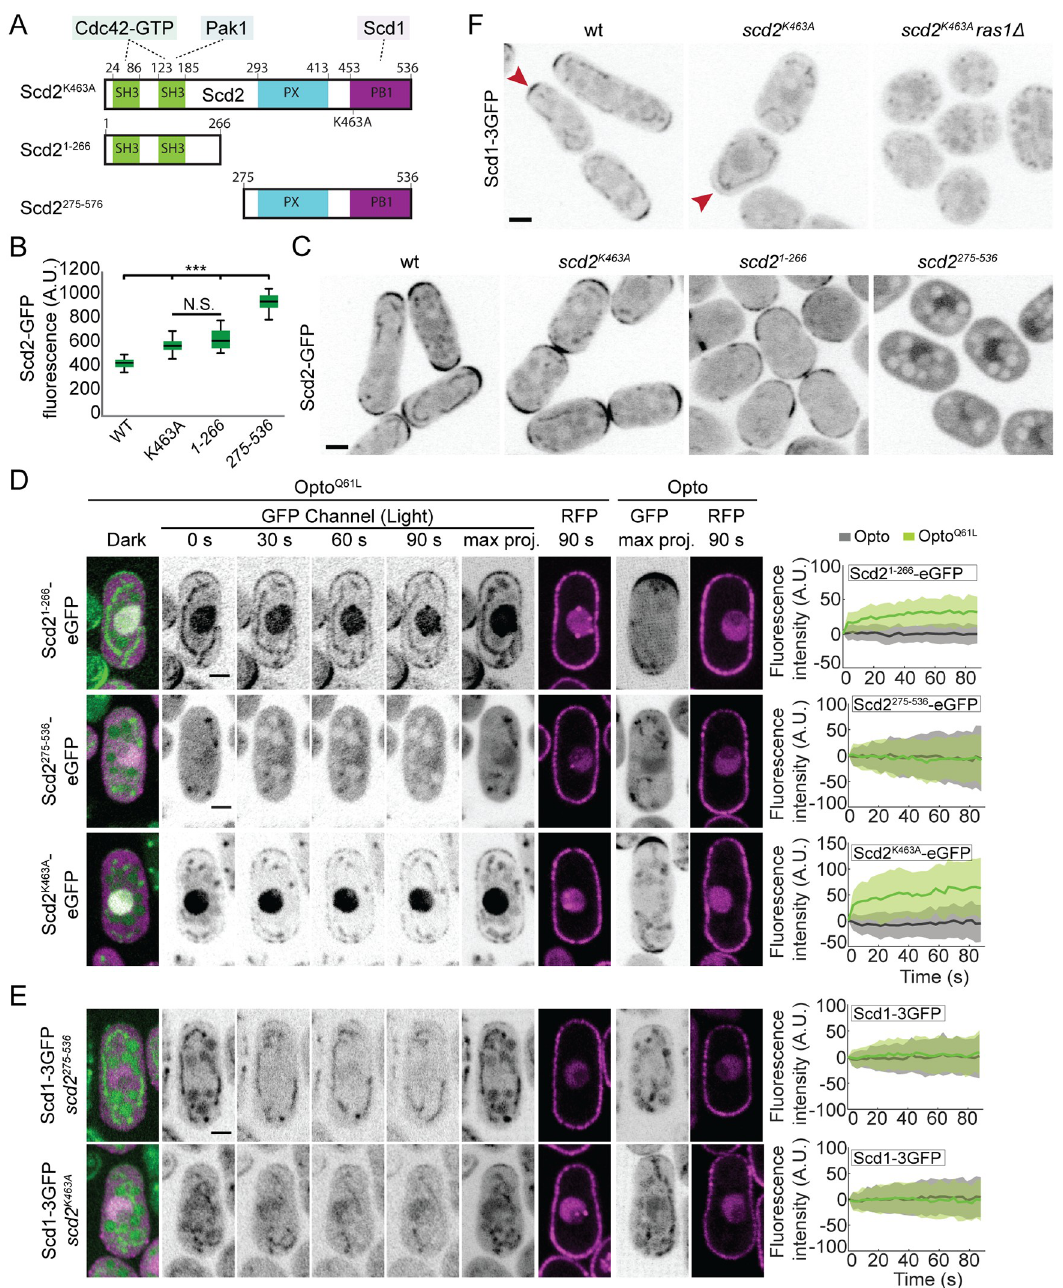
Fig 5. Structure-function dissection of Scd2 in positive feedback. (A) Schematics of Scd2 showing interaction domains with Cdc42-GTP (SH3 1 and 2), Pak1 (SH3 2), and Scd1 (PB1) [37, 38, 46], with point mutation used to block Scd1 binding (top; Scd2 K463A ; [50]) and N- and C-terminal Scd2 1-266 and Scd 275-536 fragments (bottom). The PX domain likely binds phosphoinositides [51, 52]. (B) Quantification of Scd2-GFP total fluorescence in strains as in (C). (C) Localization of Scd2-GFP (B/W inverted images) in cells expressing different alleles integrated at the endogenous scd2 locus: scd2 wt , scd2 K463A , scd2 1-266 , and scd2 275-536 . (D) Opto Q61L induces the relocalization of Scd2 1-266 and Scd2 K463A but fails to recruit Scd2 275-536 . Data layout as in Fig 3C. N = 3; n > 20 cells; p scd2(1–266) -eGFP = 3.9e -23 , p scd2(275–536) -eGFP = 0.69 and p Scd2K463A-eGFP = 4.4e -21 . (E) Opto Q61L fails to recruit its own GEF Scd1 in scd2 275-536 and scd2 K463A mutants. Data layout as in Fig 3A. N = 3; n > 20 cells; in scd2 275-536 , p Scd1-3GFP = 0.2; in scd2 K463A , p Scd1-3GFP = 0.3. (F) Localization of Scd1-3GFP (B/W inverted images) in wt, scd2 K463A , and scd2 K463A ras1 Δ cells. In all graphs, thick line = average; shaded area = standard deviation. Bars = 2 μ m. All underlying numerical values are available in S5 Data. A.U., arbitrary units; B/W, black and white; max proj., maximum projection; N.S., not significant; PB1, Phox and Bem1 domain; SH3, Src- homology 3; wt, wild